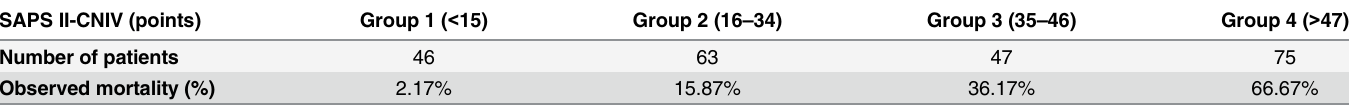
Table 7. Clinical application of SAPS II-CNIV: Death probability according to customized scores. SAPS II-CNIV (points)